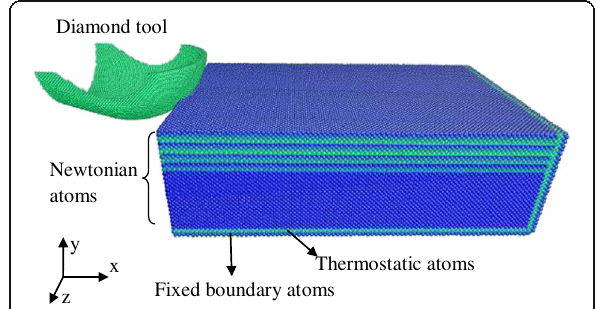
Fig. 1 MD simulation model of nanometric